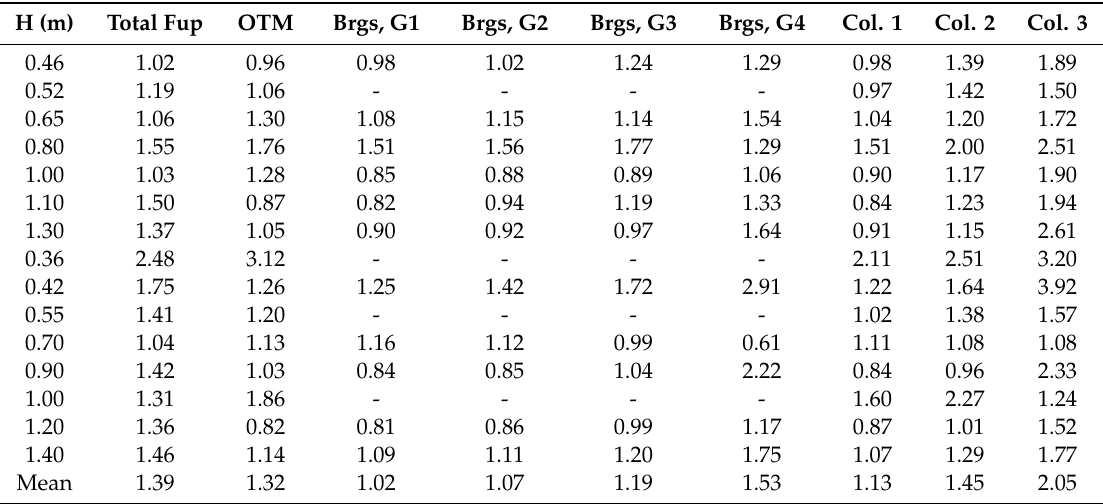
Table 5. Ratios of maximum total uplift forces, moments, and uplift forces in individual bearings and columns of the deck with solid diaphragms to the respective values of the deck with cross-frames. H (m) Total